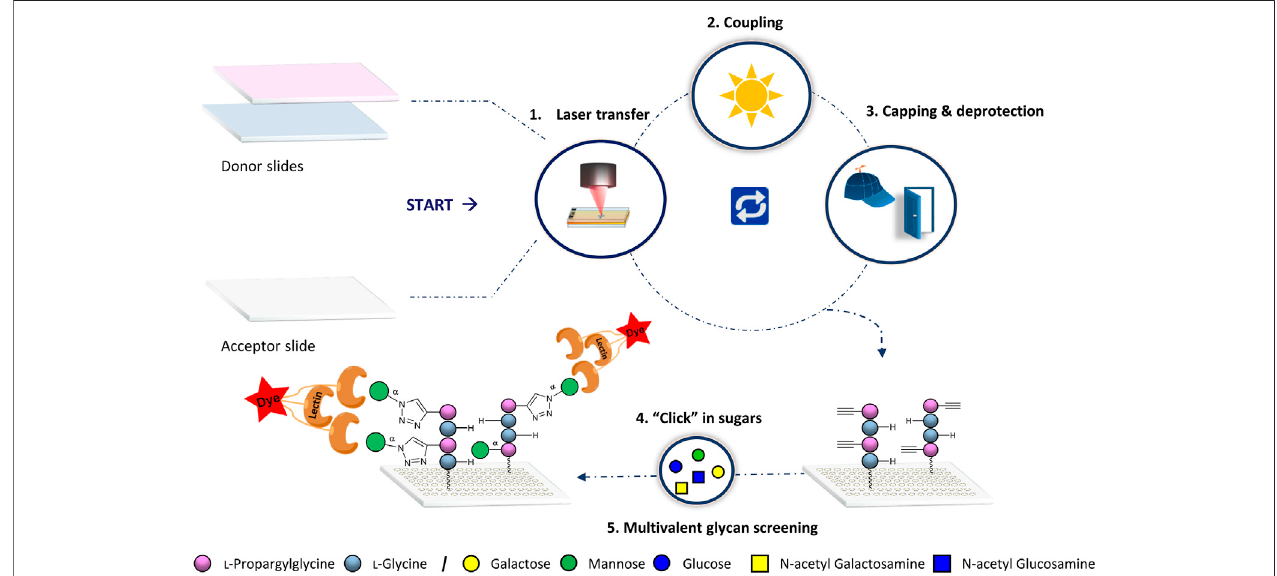
FIGURE 1 | General synthetic approach for glycopeptide generation. Synthesis consists of the 1) laser transfer process, 2) coupling of the amino acids on de fi ned spots, 3) capping to mask unreacted amine groups with subsequent deprotection of the Fmoc protecting group for the next coupling step, and 4) attachment of the sugar azides on the peptide scaffolds by CuAAC. Finally, 5) binding of lectins is screened for multivalent interactions.